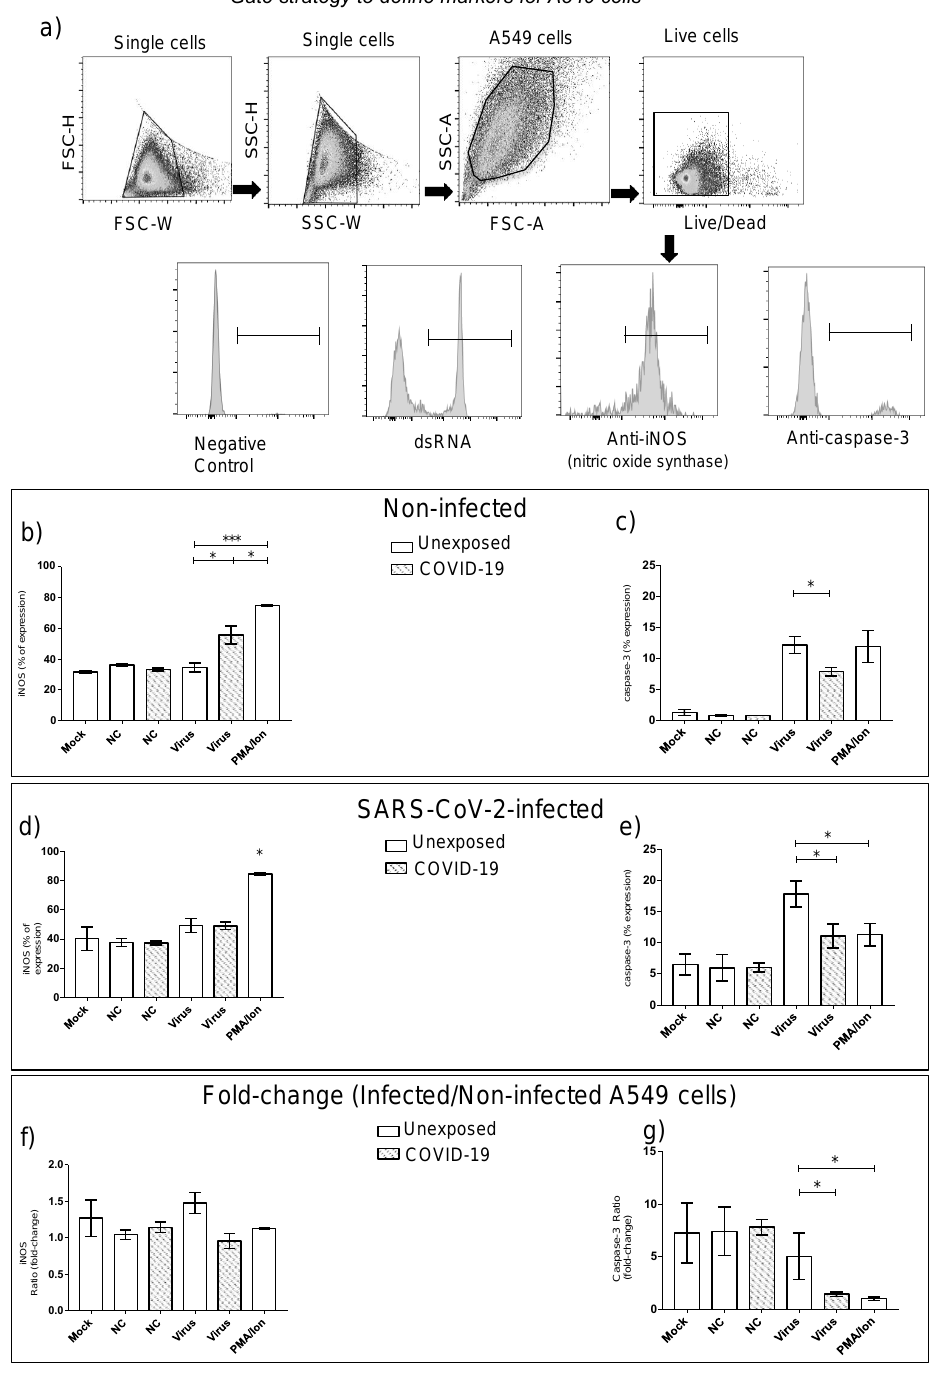
Figure 7. Effects of supernatant from PBMC cell cultivation on lung alveolar epithelial cells. A549 cell data of nitric figure 7 oxide synthase (iNOS), double-strand RNA (dsRNA), and caspase-3 expression evaluation ( a ). Data from the supernatant from unexposed and COVID-19 PBMC cultivation with live SARS-CoV-2 expressing iNOS ( b ) and caspase-3 ( c ) in A549 noninfected cells. Data from the A549 cells expressing iNOS ( d ) and caspase-3 ( e ) after 48 h of SARS-CoV-2 infection. The fold-change (infected/noninfected) of iNOS ( f ) and caspase-3 ( g ) expression by A549 cells. The supernatant pool from unexposed and COVID-19 PBMC on incubation with SARS-CoV-2 was used. PMA/Ion: Supernatant from proliferative T-cell responses stimulated by polyclonal activator. NC- supernatant from negative control used in the antigen-stimulation assay. The data are representative of 2–5 different experiments. * p < 0.05, ** p < 0.01, and *** p <